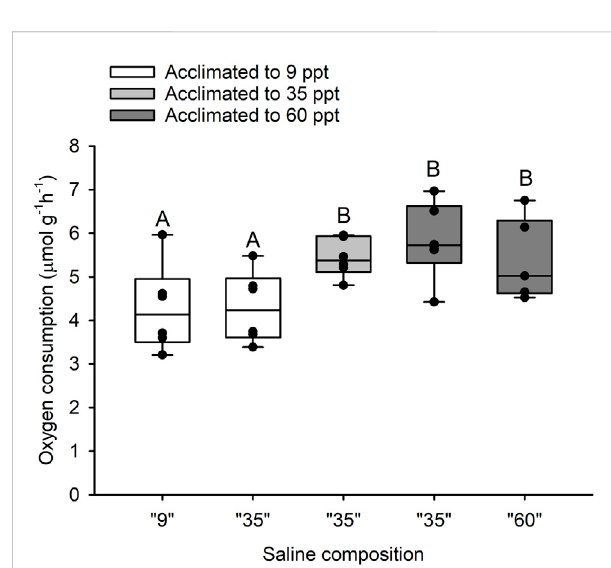
FIGURE 3 Oxygen consumption rate by isolated anterior intestinal epithelia from toad fi sh acclimated to 9 (open boxes), 35 (light grey) and 60 (dark grey) with different luminal salines representative of in vivo intestinal fl uid composition at 9, 35 and 60 ppt ( X -axis). Median, range, upper and lower quartile as well as individual observations. N = 6 for 9, 35 and 60 ppt. Groups labelled with different letters are statistically signi fi cant different ( p <